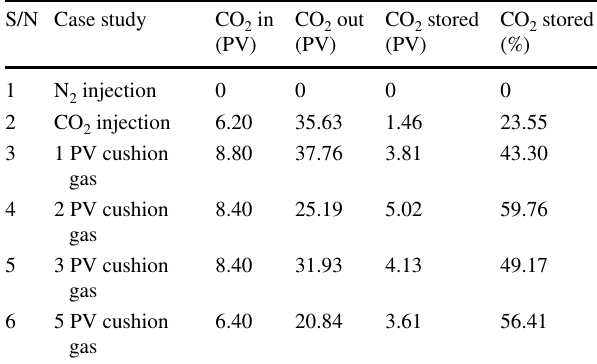
Table 3 CH 4 recovery factor evaluation for all the injection runs